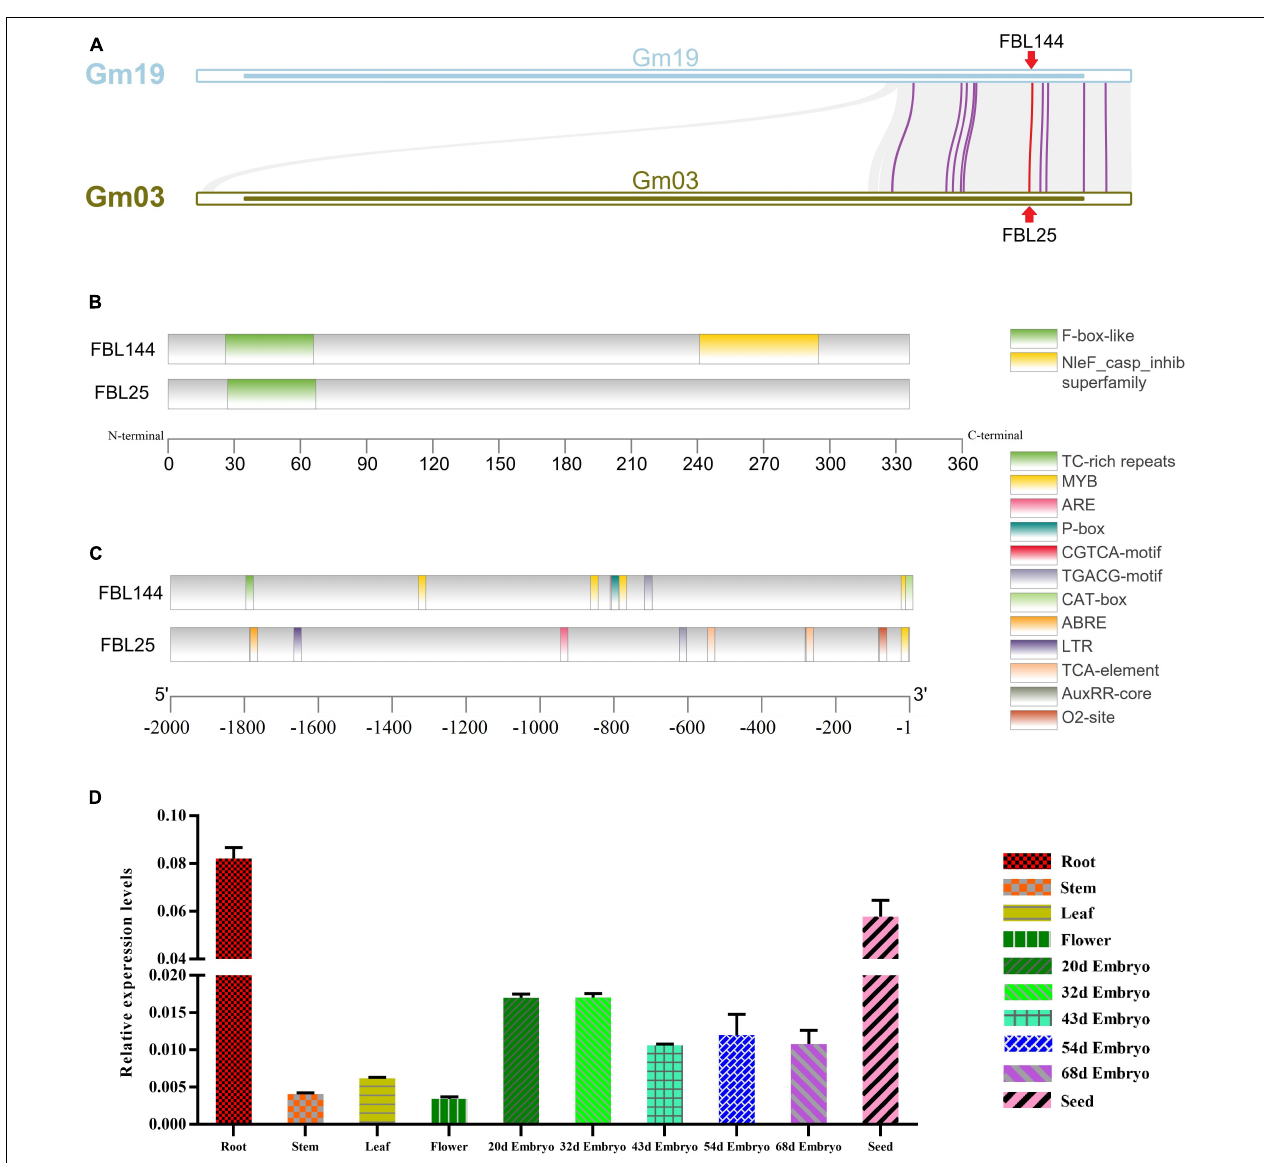
FIGURE 2 | Collinearity analysis and the structural and expression profile analysis of GmFBL144 . (A) Collinearity analysis between chromosome 19 and chromosome 3. (B) Gene structure analysis of GmFBL144 and GmFBL25 . GmFBL144 protein shares an F-box domain with GmFBL25, and GmFBL144 has an additional NleF_casp_inhib domain. (C) Promoter region analysis of GmFBL144 and GmFBL25 . The GmFBL144 promoter contains four drought response elements (MYB motif) and one stress response element (TC-rich repeats). The GmFBL25 promoter contains only one drought response element (MYB motif). (D) Expression profile analysis of GmFBL144 . The expression of GmFBL144 in roots, stem, leaves, flowers, embryos of different stages, and seeds. Relative gene expression was calculated using the 2 − (cid:49) Ct method. Data represent means ± SE of three biological